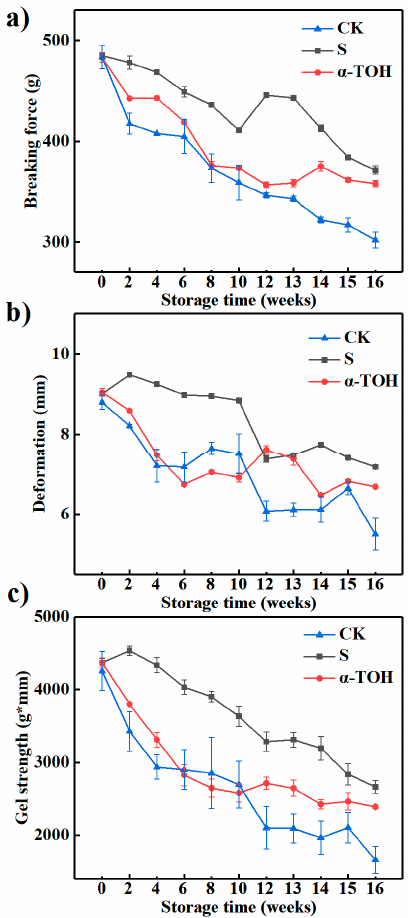
Figure 5. Effects of α -TOH on the breaking force ( a ), deformation ( b ) and gel strength ( c ) of sturgeon surimi during 16-week frozen storage at − 18 °C. Bars represent the standard deviation from triplicate determinations ( n = 3; 3 means 3 replicates).